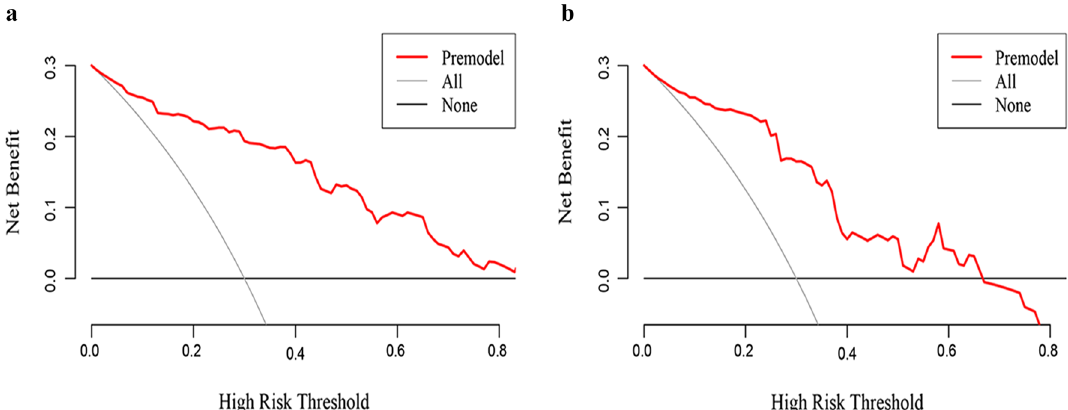
Fig. 6 The DCA curve for predicting the occurrence of ACLF within 90 days. DCA analysis showed that the model had an overall good net benefit within the wide and practical ranges of threshold probabilities and influenced patient outcomes. DCA, decision analysis curve; ACLF, acute-on-chronic liver